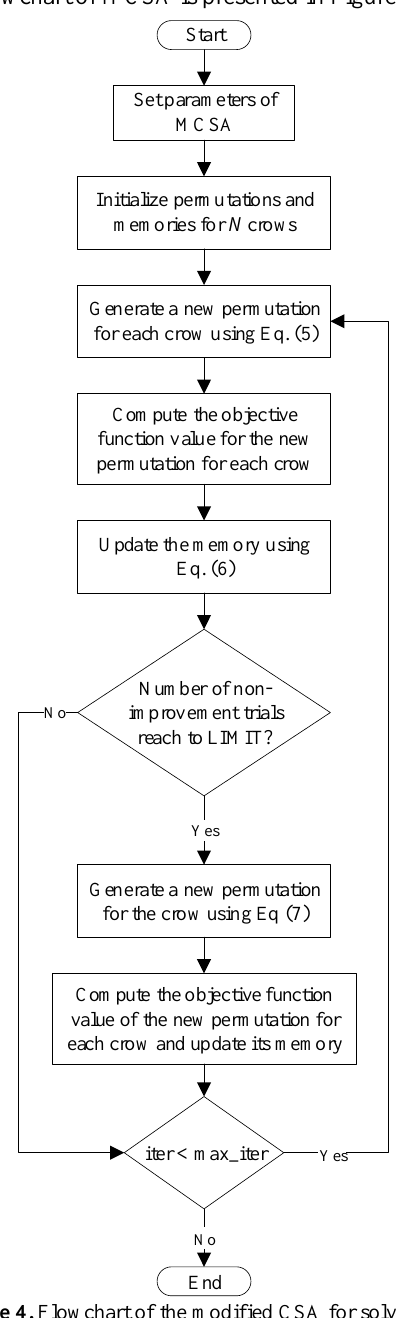
Figure 4. Flowchart of the modified CSA for solving the WTA